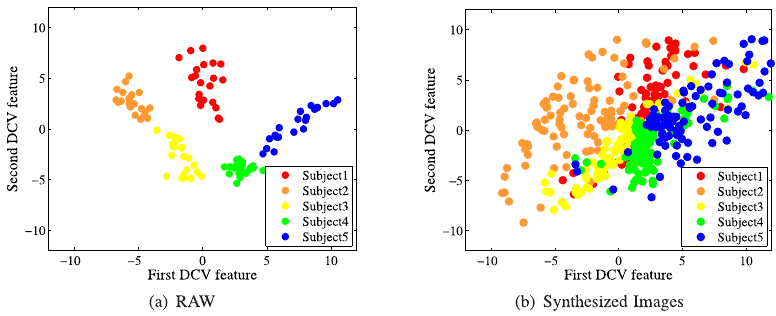
Figure 3. Distributions of samples for five subjects in the two-dimensional Discriminative Common Vector (DCV) feature space: ( a ) real images; and ( b ) synthesized images (proposed